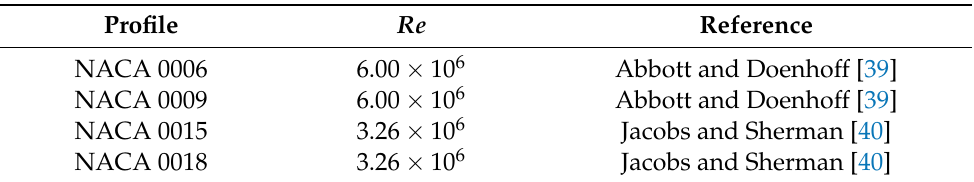
Table 29. More profiles